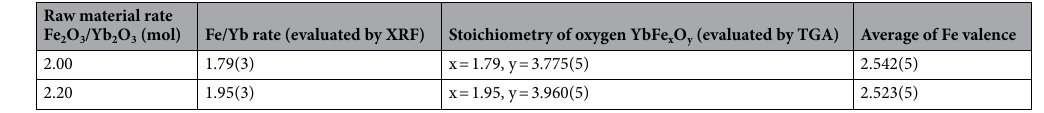
Table.1. The sample stoichiometry of YbFe 2 O 4